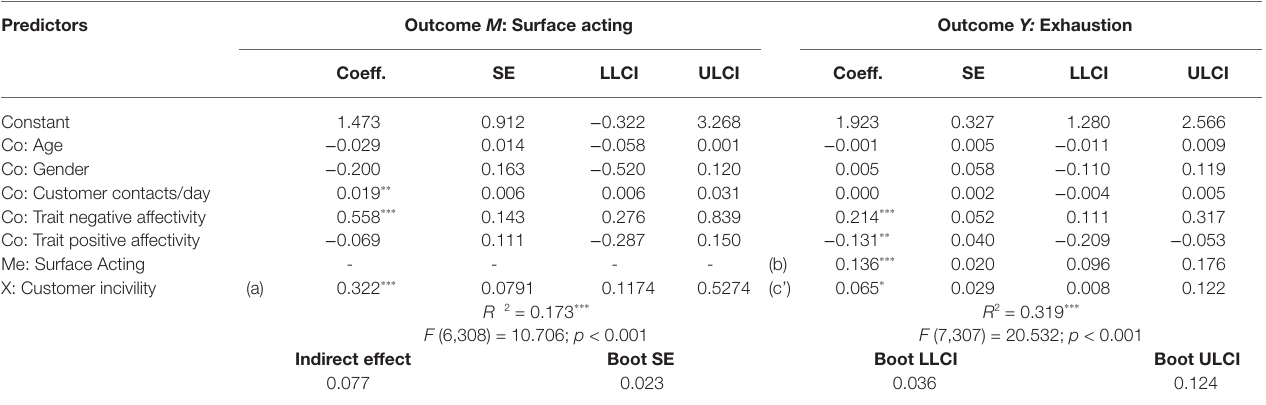
TABLE 2 | Coefficients for the tested mediation model. Predictors Outcome M : Surface acting Outcome Y: Exhaustion Coeff. SE LLCI ULCI Coeff. SE LLCI Constant